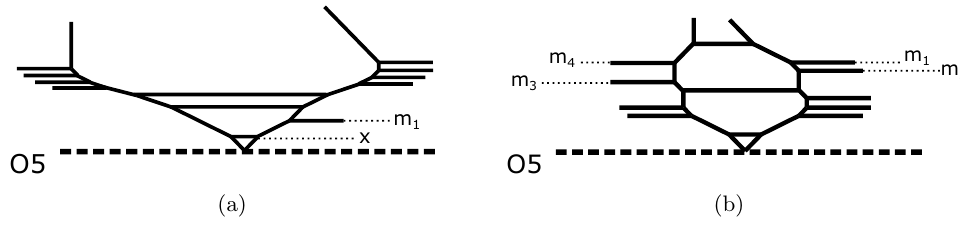
Figure 10 . (a). The 5-brane web diagram for the Sp(2) gauge theory with nine (cid:13)avors in a phase where the line of the length (3.11) can be seen. (b). The 5-brane web diagram for the Sp(2) gauge theory with nine (cid:13)avors in a phase where the line of the length (3.12) can be